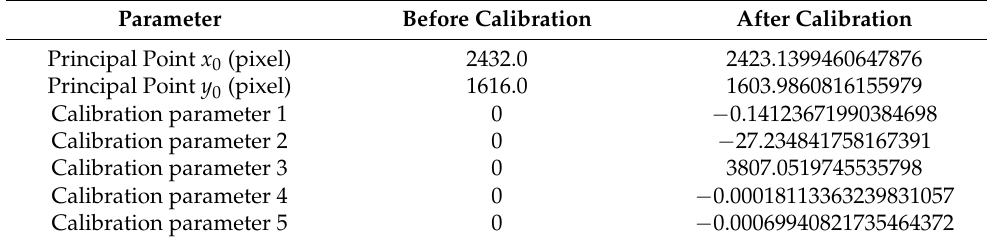
Figure 11. Sparse Point Cloud After the Third Experiment. Table 5. The intrinsic parameters before and after